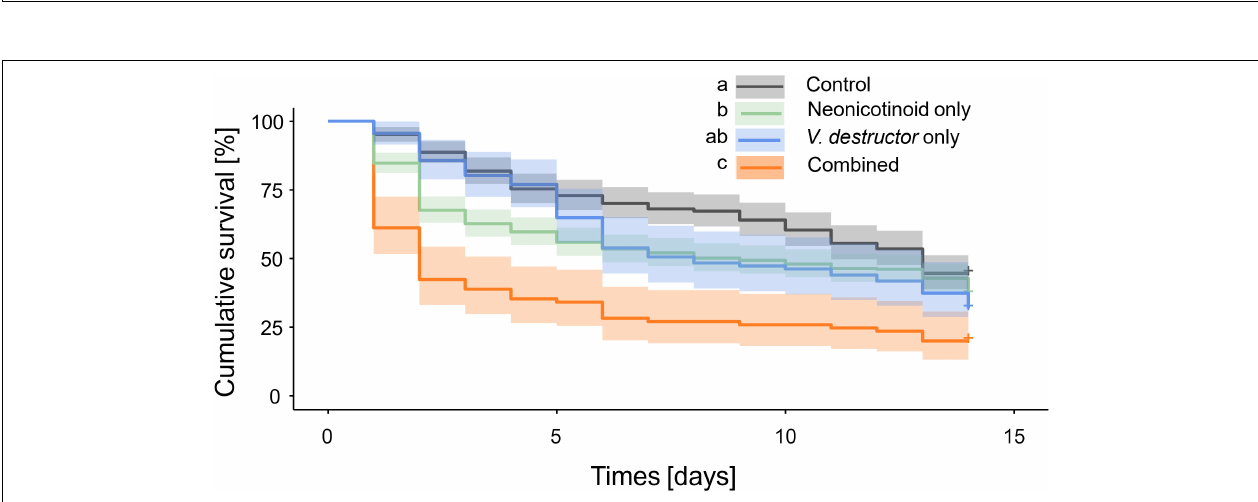
FIGURE 2 | Kaplan-Meier survival curves of experimental western honey bee ( Apis mellifera ) drones during a 14-day laboratory cage assay. Summary of survival curves for all four treatment groups: Control—drones without neonicotinoid exposure and without Varroa destructor parasitism, Neonicotinoid only—drones exposed to neonicotinoids during development but free from V. destructor parasitism, V. destructor only—drones parasitized by V. destructor during development but not exposed to neonicotinoids, and Combined—drones exposed to both neonicotinoids and V. destructor during development. Different letters placed before treatment groups indicate statistically significant differences ( p ≤